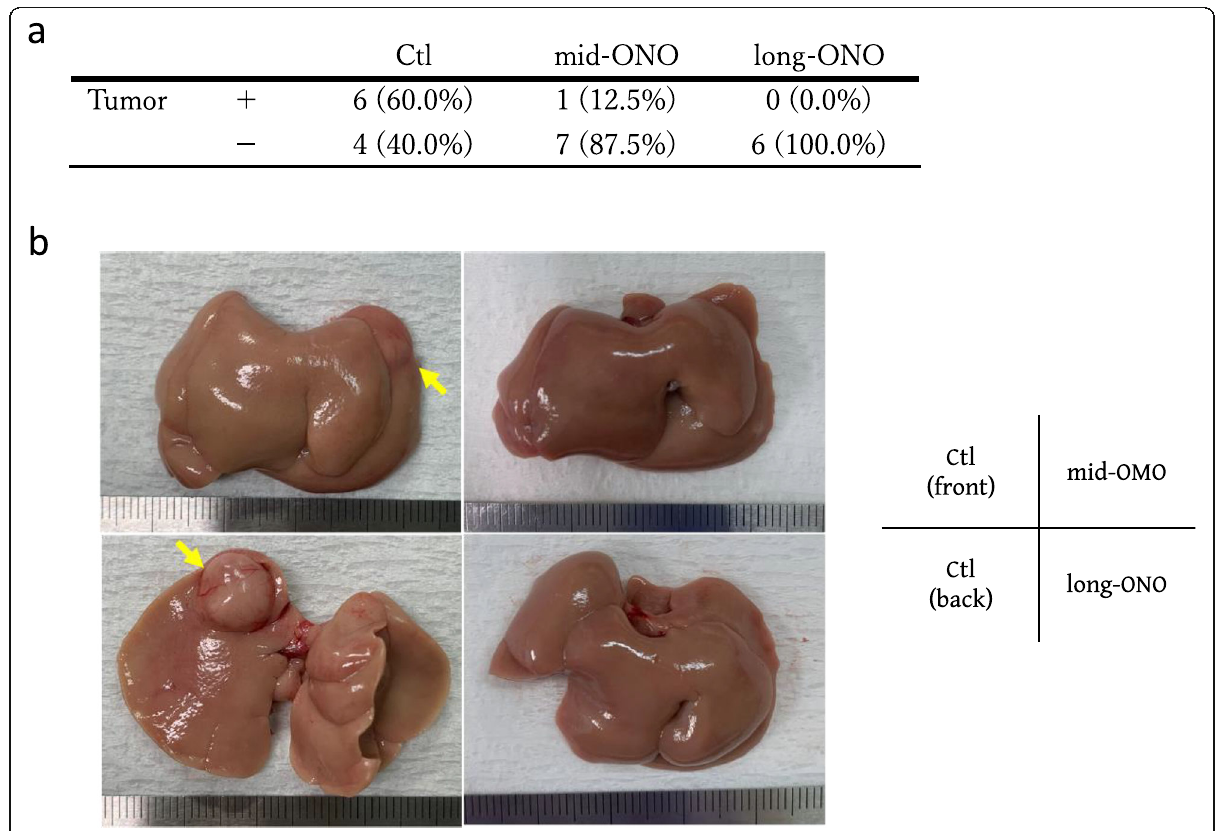
Fig. 3 Evaluation of liver tumor occurrence in Mc4r -KO NASH model mice at 36 weeks of age. A Tumor incidence in each group. B Macroscopic images of the liver tumors. Total number of mice in each group: n = 10 in Ctl group, n = 8 in mid-ONO group, n = 6 in long-ONO group. Yellow arrows indicate the liver